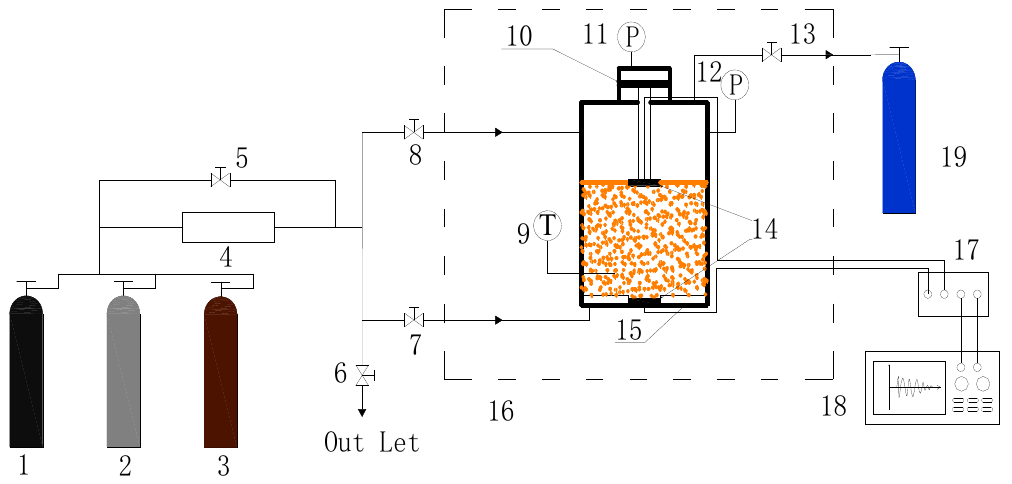
Figure 1. Schematic diagram of experimental apparatus for measuring P-wave velocity during CH -CO replacement process. 1: N 4 2 4: Gas mass meter; 5–8 and 13: Valve; 9: Temperature transmitter; 10: Piston; 11 and